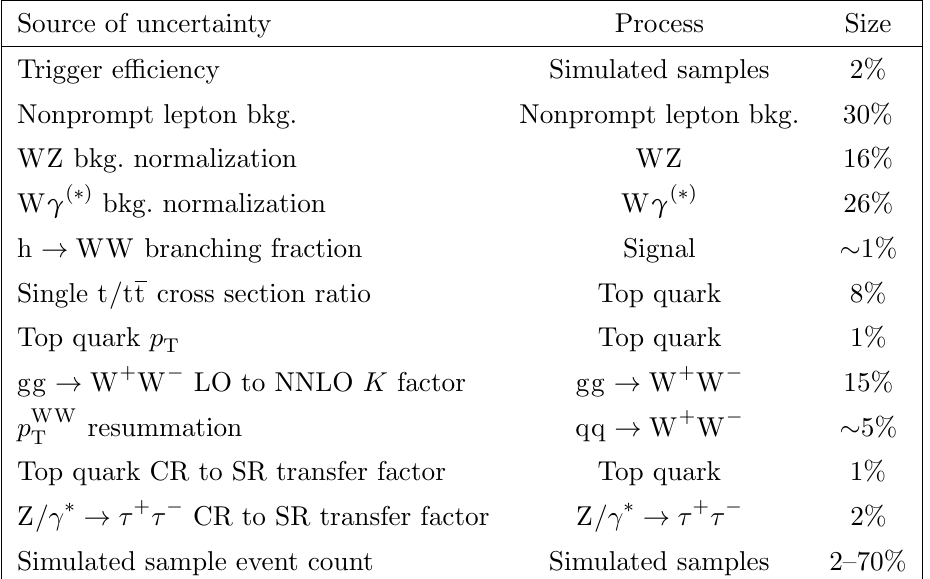
Table 3 . Systematic uncertainties a(cid:11)ecting the h